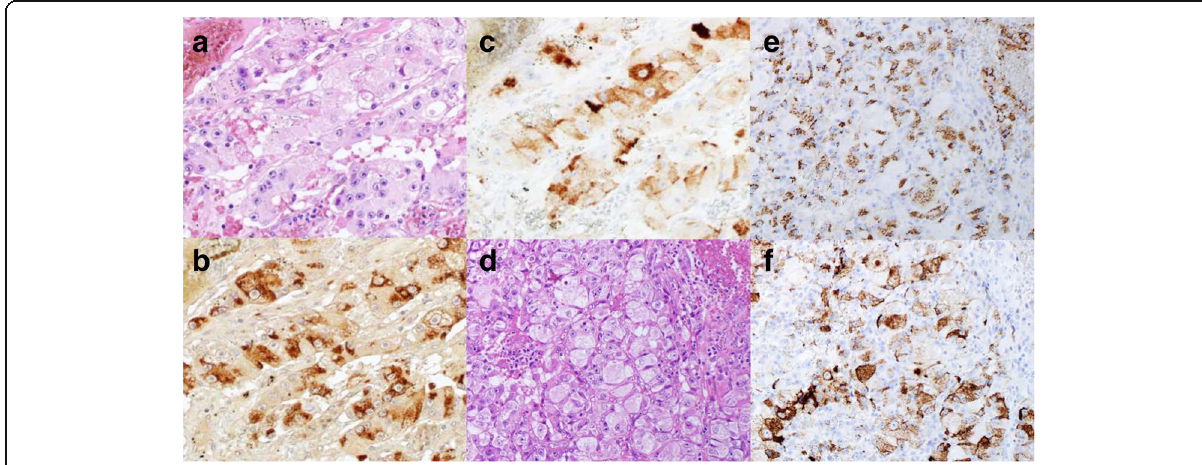
Fig. 3 Histopathological features of the mixed acinar-endocrine carcinoma. Haematoxylin and eosin image of the pancreas tumour, 100× ( a ). Immunostaining of the pancreas tumour for trypsin 100× ( b ) and chromogranin A 100× ( c ). Haematoxylin and eosin image of the gastric tumour, 50× ( d ). Immunostaining of the gastric tumour for trypsin 50× ( e ) and chromogranin A 50× ( f